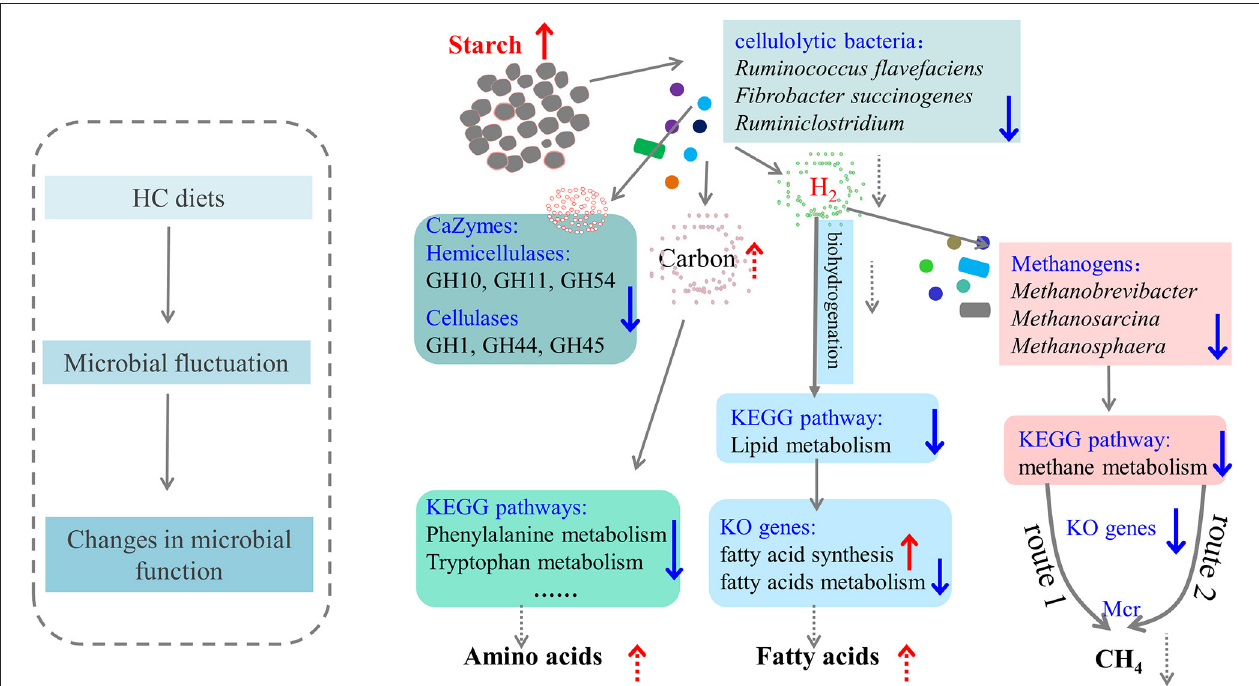
FIGURE 7 | The proposed schematic diagram of how high-concentrate (HC) diets affected the hindgut microbiota and metabolic functions of dairy cows. The up arrows indicated this microbial taxa or function increased or enhanced in the HC group compared with the low-concentrate group. The dotted line was the speculated concept based on these results in the present study, which needed to be confirmed by future